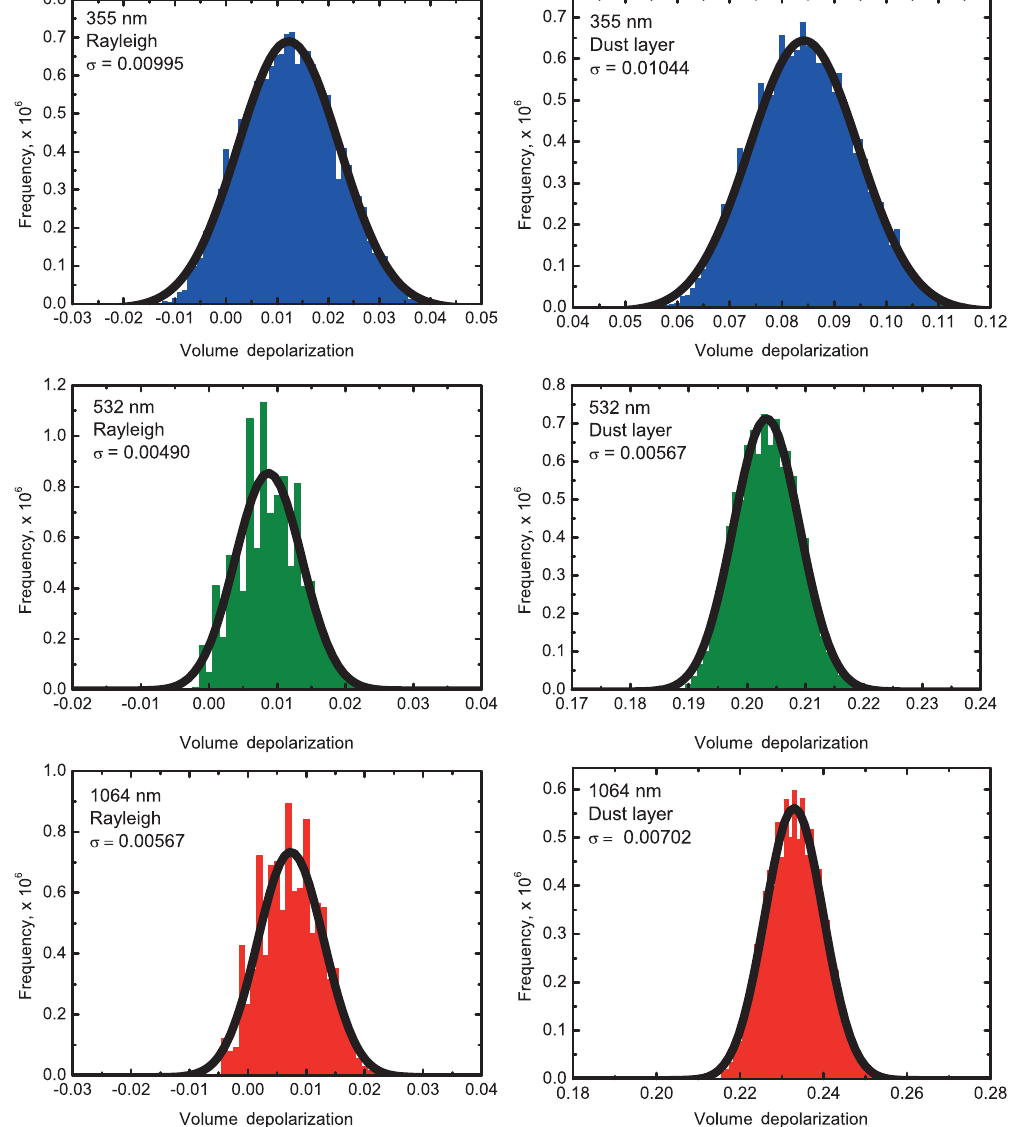
Figure A1. Frequency distribution (in millions of individual computations) of the volume depolarization ratio derived by a Monte Carlo simulation of the system parameters of the BERTHA lidar system (Table A1) within their uncertainties. For each wavelength the Rayleigh depolarization and a typical value in the dust layer was chosen as the input value (true value), given in Table A2. The standard deviation σ of the Gaussian fit (black line) is given to estimate the error of the volume depolarization